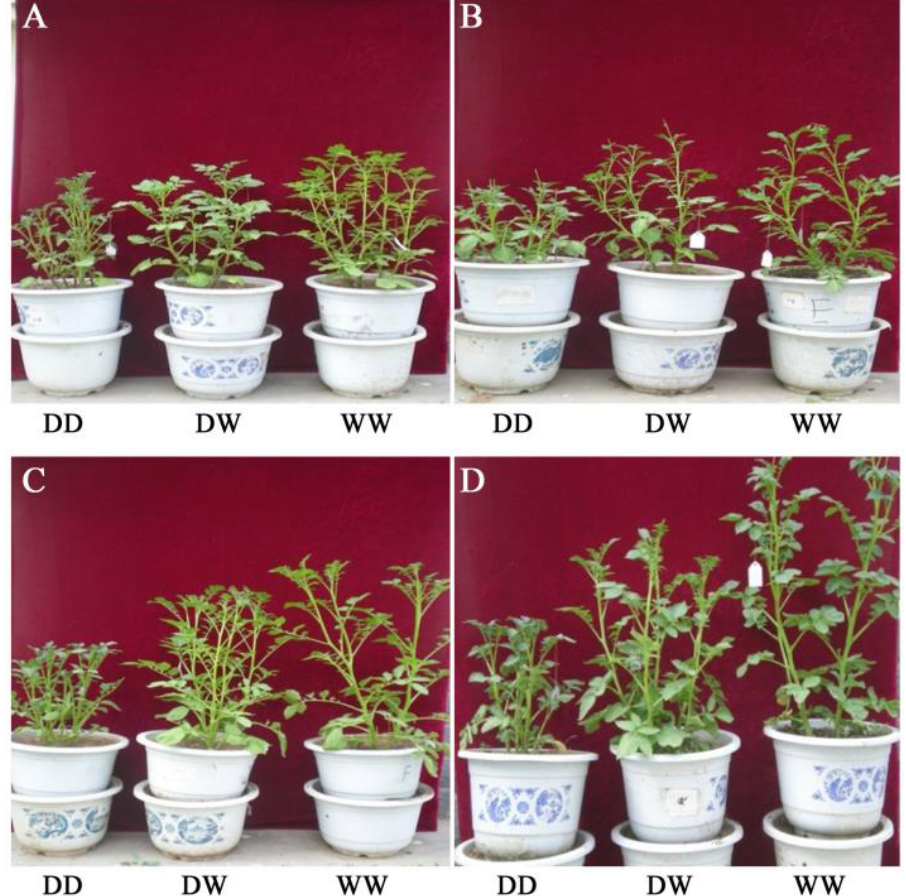
Figure 1. Phenotypes of four varieties under different irrigation conditions. ( A ): Favorita, ( B ): At- lantic, ( C ): Longshu No.3, ( D ): Xindaping. DD (drought): After the beginning of treatment, we stopped watering the top and bottom pots, subjecting them to drought stress under natural condi- tions. DW (half-irrigation): After the beginning of treatment, the top pots were not watered and the bottom pots were watered normally, which stimulates the phenomenon of hydraulic lift. WW (ir- rigation): After the beginning of treatment, the top and bottom pots were watered normally as controls.